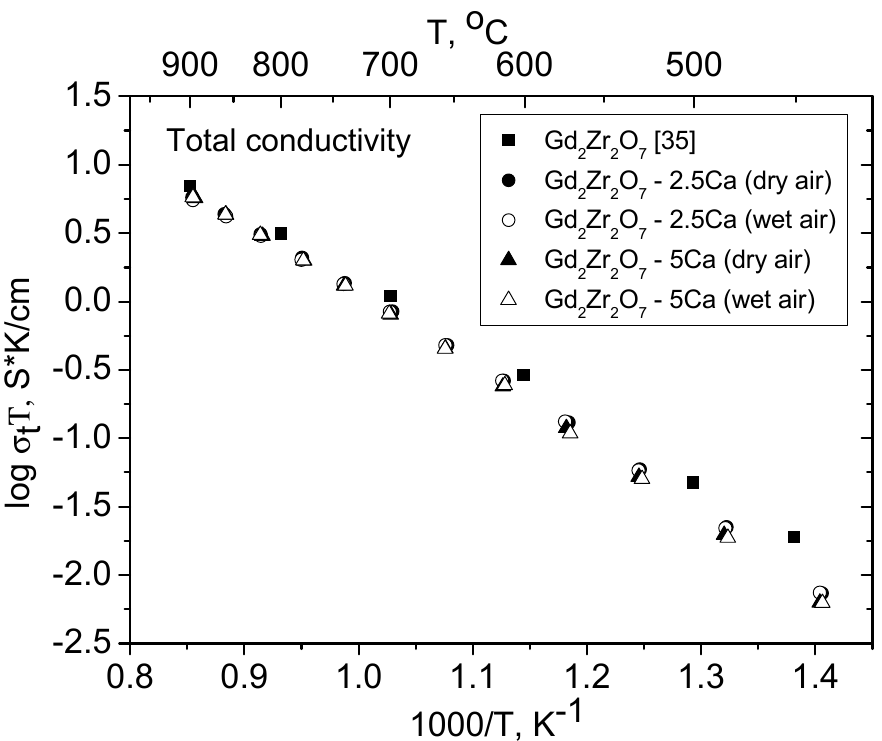
Figure 9. The total conductivity of Gd 2 − x Ca x Zr 2 O 7 − x / 2 (x = 0.05, 0.1) in dry and wet air. The bulk conductivity data for undoped Gd 2 Zr 2 O 7 in ambient air are borrowed from Moreno et al. [35].